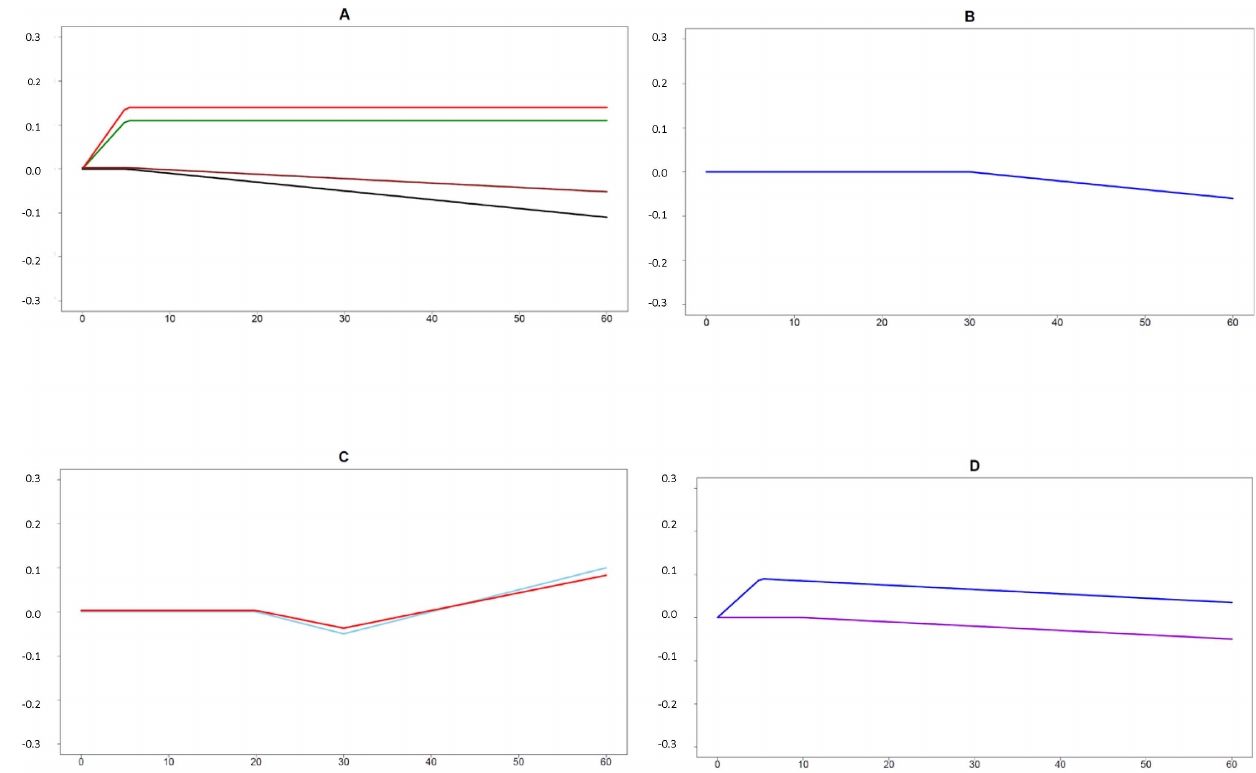
Figure 3. Relationships between the quantity of smoking (x-axis) and HRQoL (y-axis, standardized scores) in current daily smokers. Panel A, men 25–44 yrs; Panel B, men 45–64 yrs; Panel C, women 25–44 yrs; Panel D, women 45–64 yrs. Colors: physical functioning (black); role limitations due to physical problems (skyblue); bodily pain (green); general health (brown); vitality (violet); role limitations due to emotional problems (red); mental health (dark blue); only subscales with significant thresholds are shown.